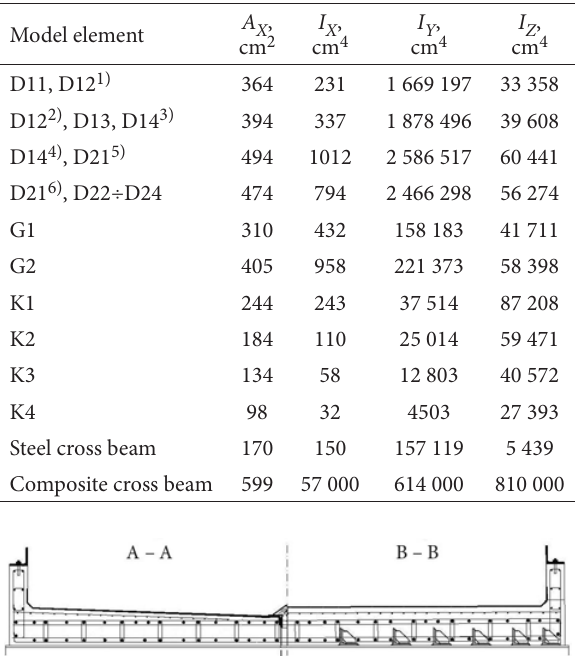
Fig. 8. Cross-section of deck slab: in-between cross beams